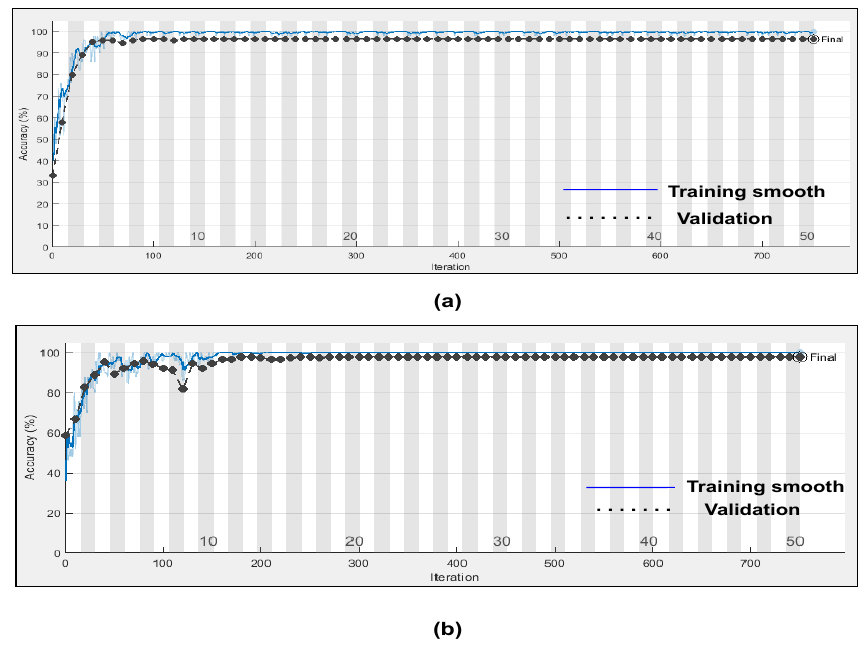
Figure 13. ( a ) Training progress and validation accuracy of proposed model with dropout regulariza- tion ( b ) training and progress accuracy of proposed model without dropout